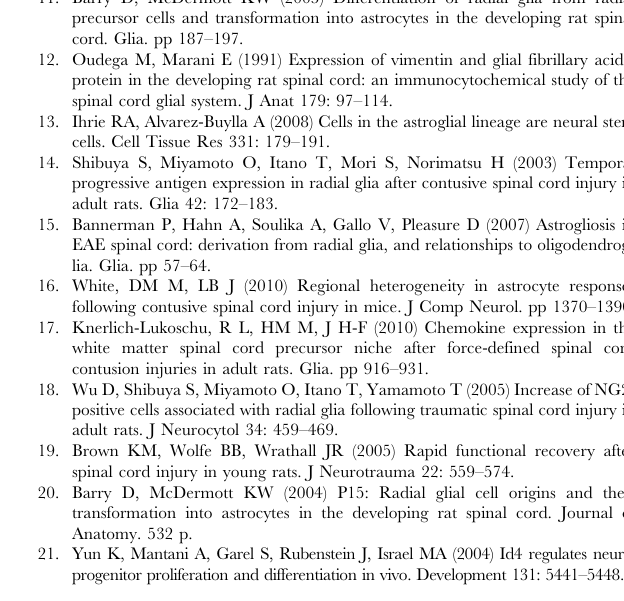
Figure S2 Progenitor Gene Expression in Adult SCRG. Confocal z-stack images of neural progenitor markers in (D–F) adult SCRG. (A–B) SCRG express nestin robustly in the adult. (B) In adult SCRG, GFP + processes (green) co-express VIM (blue) more abundantly than in neonatal. Their nuclei remain at the sub- pial edge of SC and small subpopulations retain expression of (A, C) SOX2 (blue) and (C) PCNA (red). The reduction in progenitor marker expression from neonatal to adult observed in the CC (Figure 4) is also reflected in SCRG. Arrow: process; double arrowhead: double-positive cell; double arrow: SCRG; dotted line: marginal edge of SC; Vim: Vimentin; BV: blood vessel. Scale bars: 50 m m. Figure S3 SCRG Express NSC Proteins in the Neonatal SC and Retain Progenitor-like Morphology and Expres- sion Profile in Adult. (A, C) Confocal z-stack images of cross- sectioned SC from neonatal (PND 5) mice. (C) BLBP + (green) SCRG processes (double arrow) begin at the marginal edge of the SC and extend through the WM, and subpopulations co-express (A) VIM (red) but rarely NES (green) and (C) their nuclei contain PCNA (red). (B, D) Confocal z-stack images of cross-sectioned SC from adult (PND 75) mice. Although less abundant than in the neonatal SC, the (D) BLBP + (green) processes of adult SCRG also demonstrate enhanced expression of (B) NES (green). Their nuclei remain at the sub-pial edge of SC and small subpopulations retain expression of (D) PCNA (red). (B) A large subpopulation of NES-expressing cells (green) co-express VIM (red). Boxed areas outline magnified regions (A 9 –D 9 ) of the z-stack that were rotated and tilted on a 3D plane to best highlight the anchored cell soma and processes at the pial boundary. (A 0 –D 0 ) Schematics of SC cross-section detail the precise expression pattern of the corresponding markers and highlight the shifting cytoarchitecture of the SCRG and CC progenitors of the